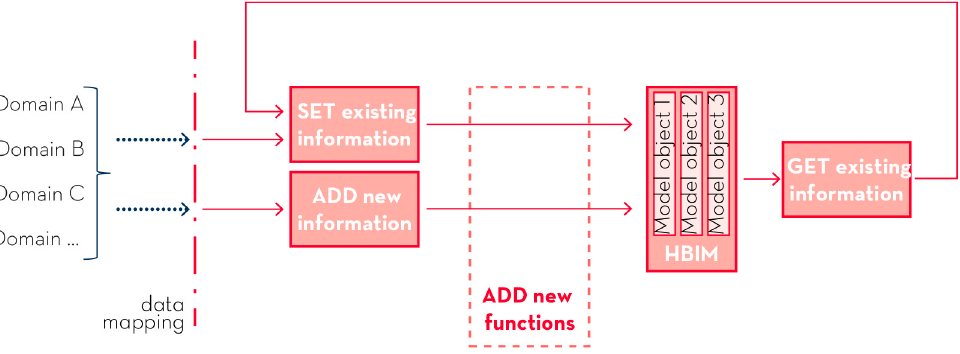
Figure 3. Recursive process of definition and implementation of HBIM object properties through the collection and manipulation of external data.